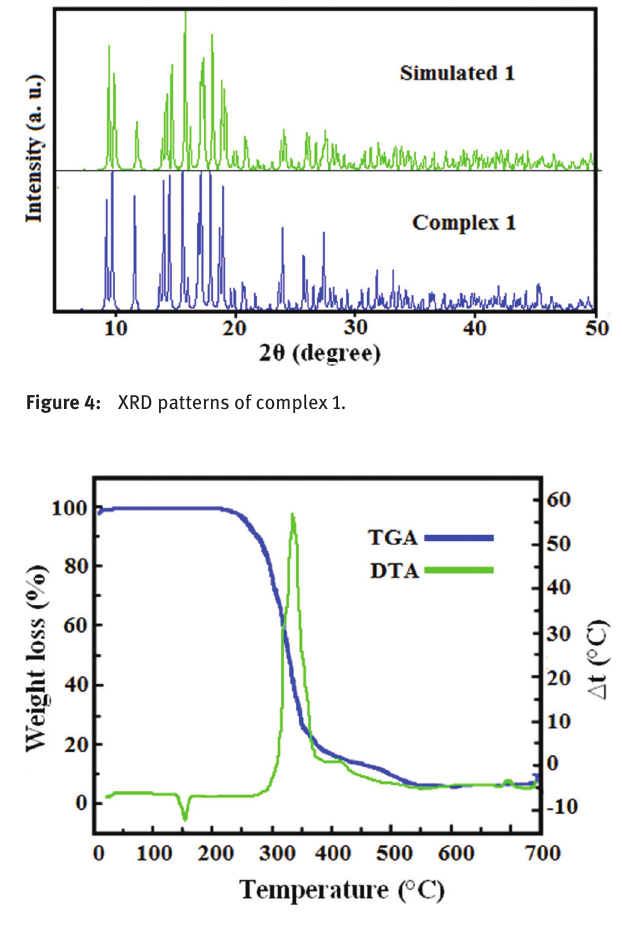
Figure 5: TGA diagram of complex 1 .